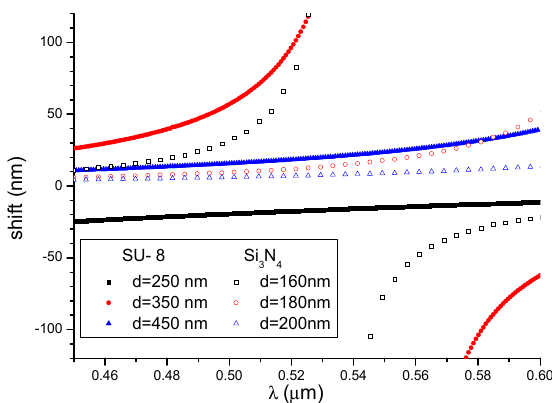
Figure 13. Shifts in the maxima for the SU-8 and Si 3 N 4 waveguides.